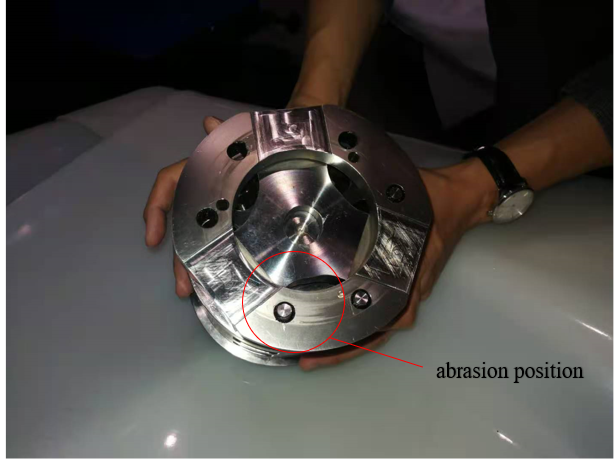
Figure 15. Abrasion of the flexible structure.